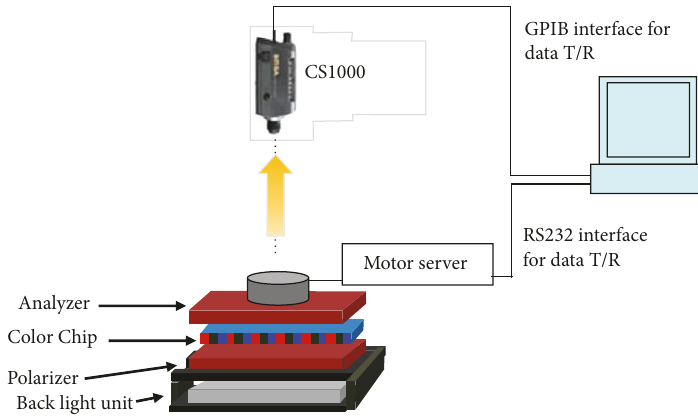
Figure 3: Auto-experimental system of measurement for contrast ratio of color resists.